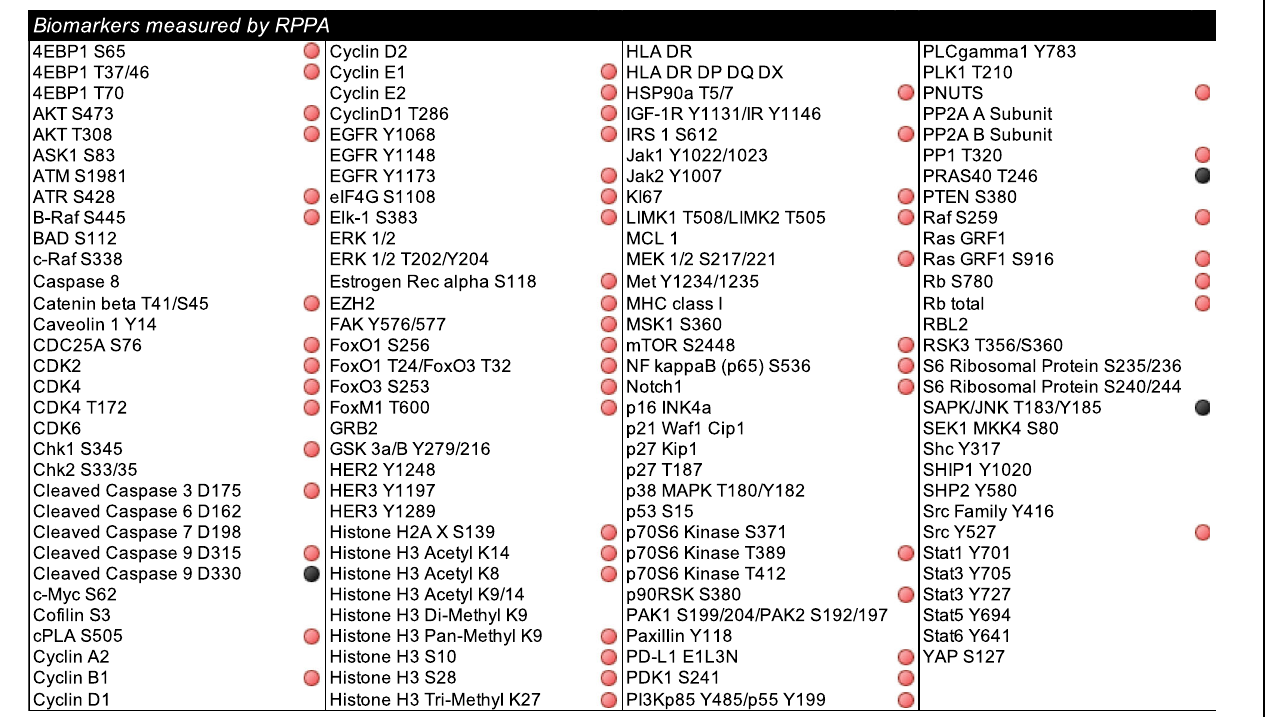
Table 2. List of proteins that reached statistical signi fi cance when responders were compared to patients with progressive disease.